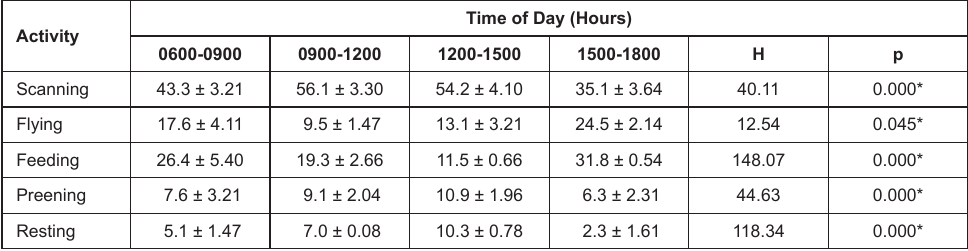
* Differ significantly (Kruskal-Wallis test, p < 0.05) between time blocks